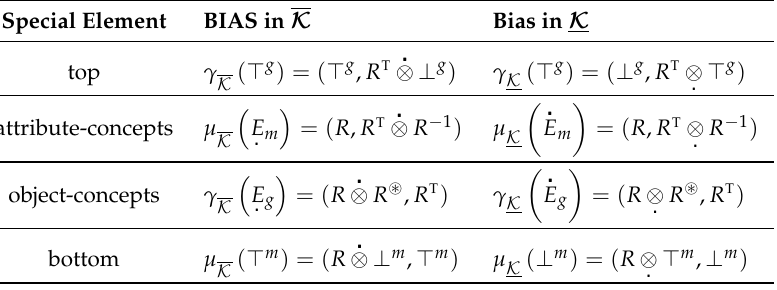
Table 1. Special elements of the concept lattices with biases in K (left column) and K (right column). Special Element BIAS in K Bias in K